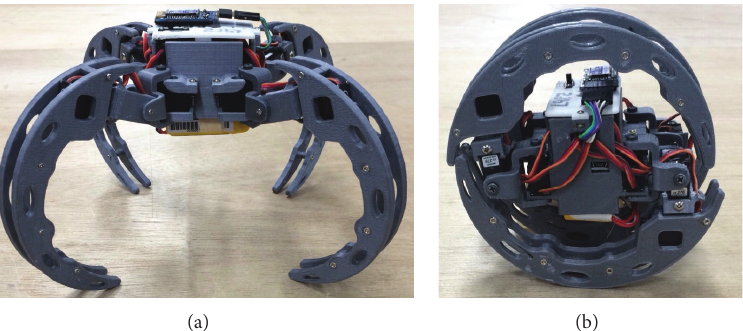
Figure 1: Huntsman-spider-inspired quadruped robot: (a) walking form and (b) rolling form. This robot has four legs and three motors on each leg, namely, twelve motors. Three motors on each leg are mounted as their axes are at right angles to each other.